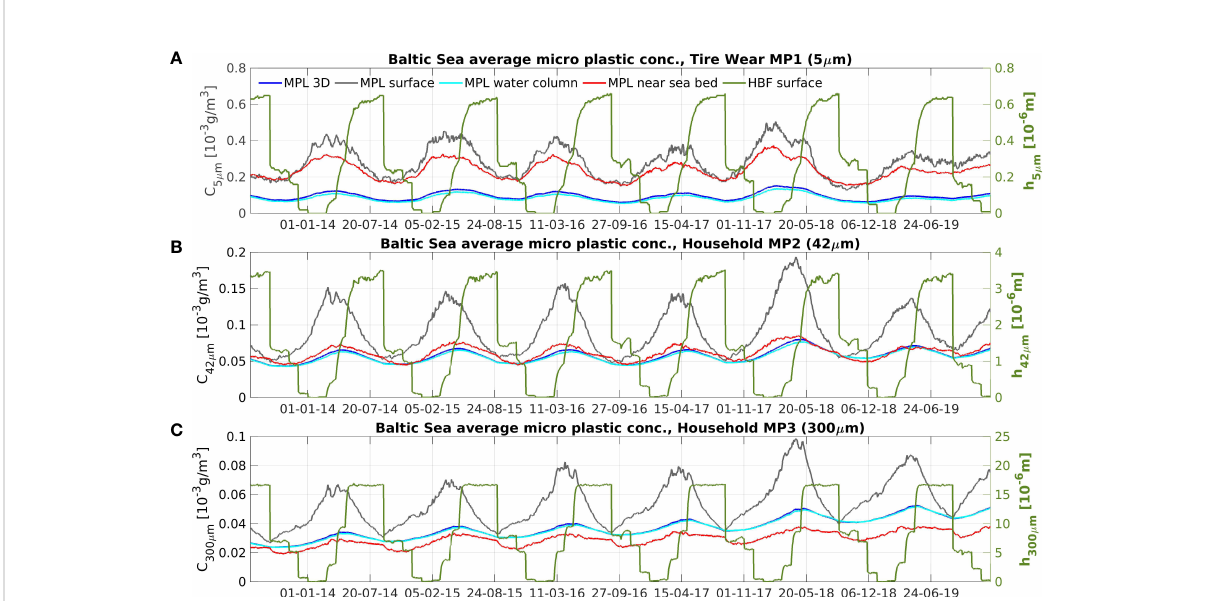
FIGURE 4 Time series of average microplastic concentration in the entire Baltic Sea: tire wear MP1 (A) and household microplastics MP2 (B) and MP3 (C) . High concentrations exist at the sea surface (gray) and near the seabed (red), which account for 4.3% of the total number of grid points. The concentrations in the remaining part of the water column (light blue) are rather similar to the concentrations in the entire Baltic Sea (dark